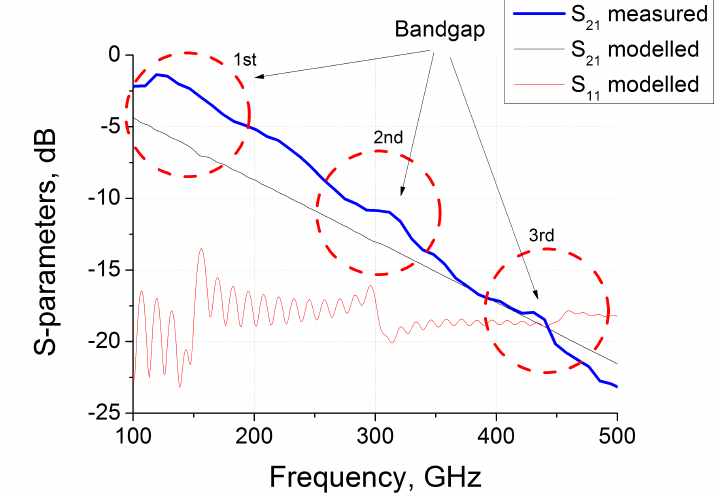
Figure 4. Experimentally measured and numerically calculated S -parameters of 9.5mm-thick gyroid samples in the free